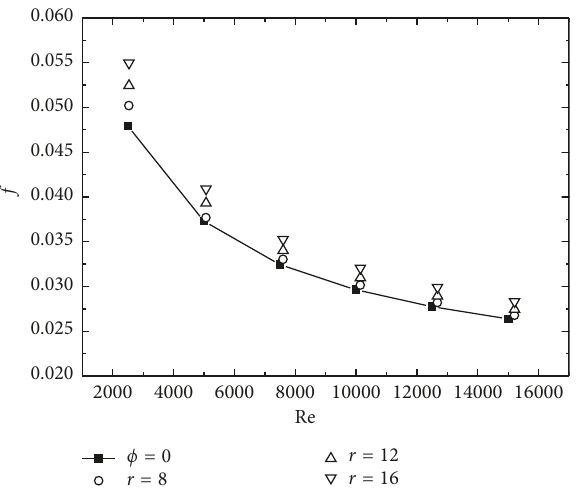
Figure 6: Friction factor as a function of the Reynolds number by different aspect ratios ( ϕ